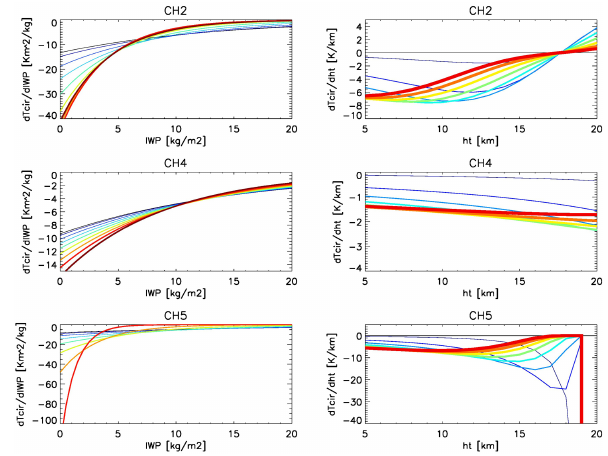
Figure 5. Analytical solutions of the two components of the Jaco- bian matrix K : ∂T cir /∂ IWP with fixed h t (left) and ∂T cir /∂h t with fixed IWP (right). For the left column, the fixed h t value increases from 6 (thin, blue) to 20km (thick, red) with an interval of 2km. For the right column, the fixed IWP value increases from 0.5 (thin, blue) to 18kgm − 2 (thick, red) with an interval of 2.5kgm − 2